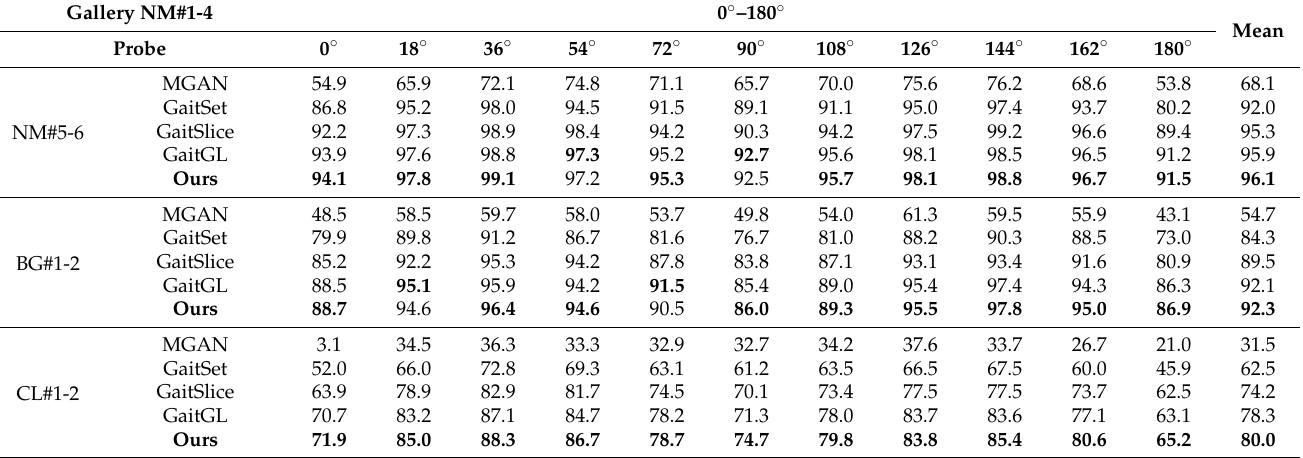
Table 3. Averaged rank-1 accuracies on CASIA-B under MT setting, excluding identical-view cases.